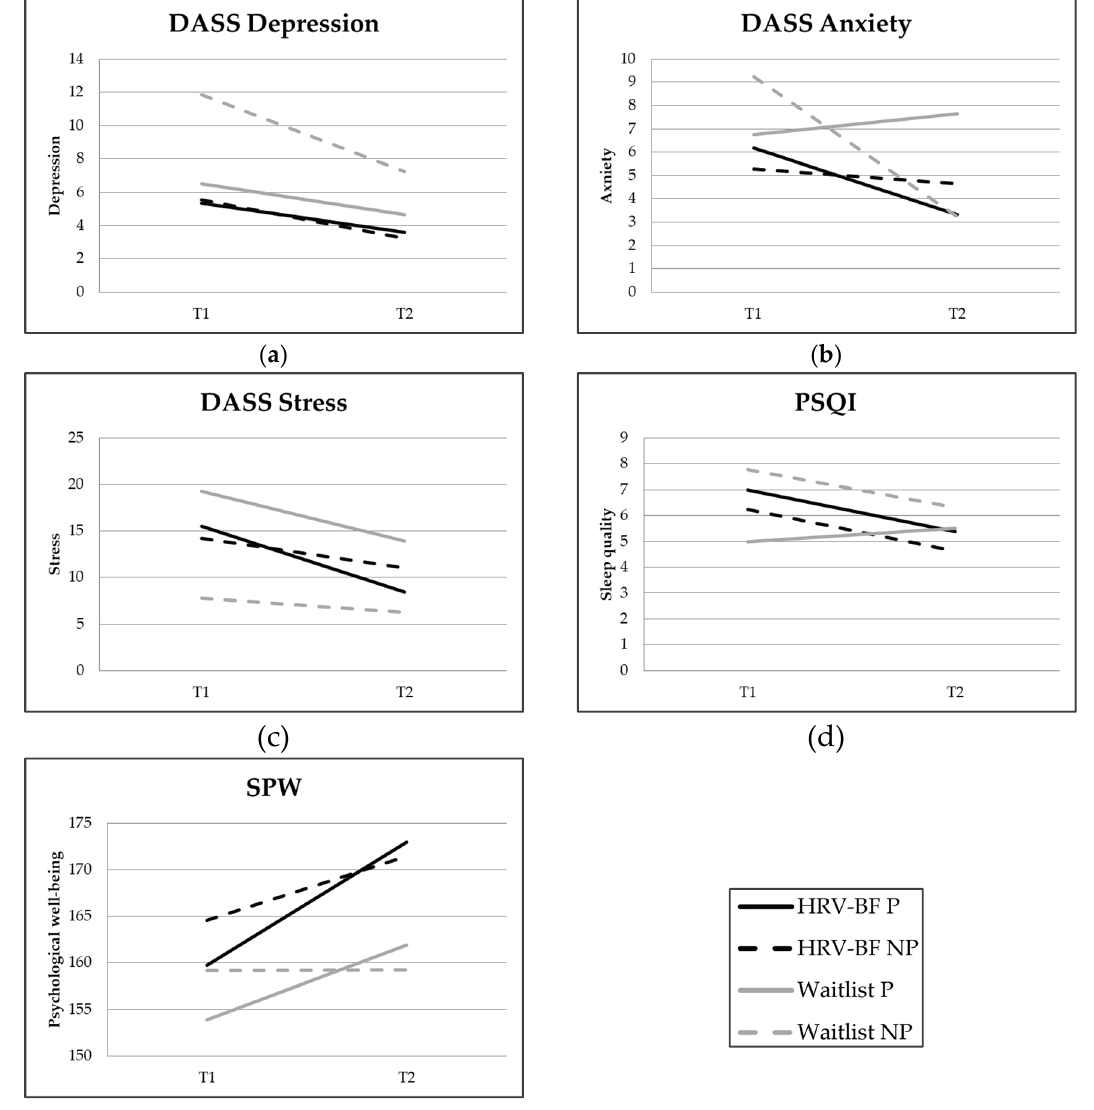
Figure 2. Mean scores on the ( a ) Depression scale of the Depression Anxiety Stress Scale (DASS); ( b ) Anxiety scale of the DASS; ( c ) Stress scale of the DASS; ( d ) Pittsburgh Sleep Quality Index (PSQI); ( e ) Scales of Psychological Well-being (SPW) per intervention condition for pregnant and non-pregnant women at pre-test (T1) and post-test (T2). Note: a higher PSQI score represents poorer sleep quality.